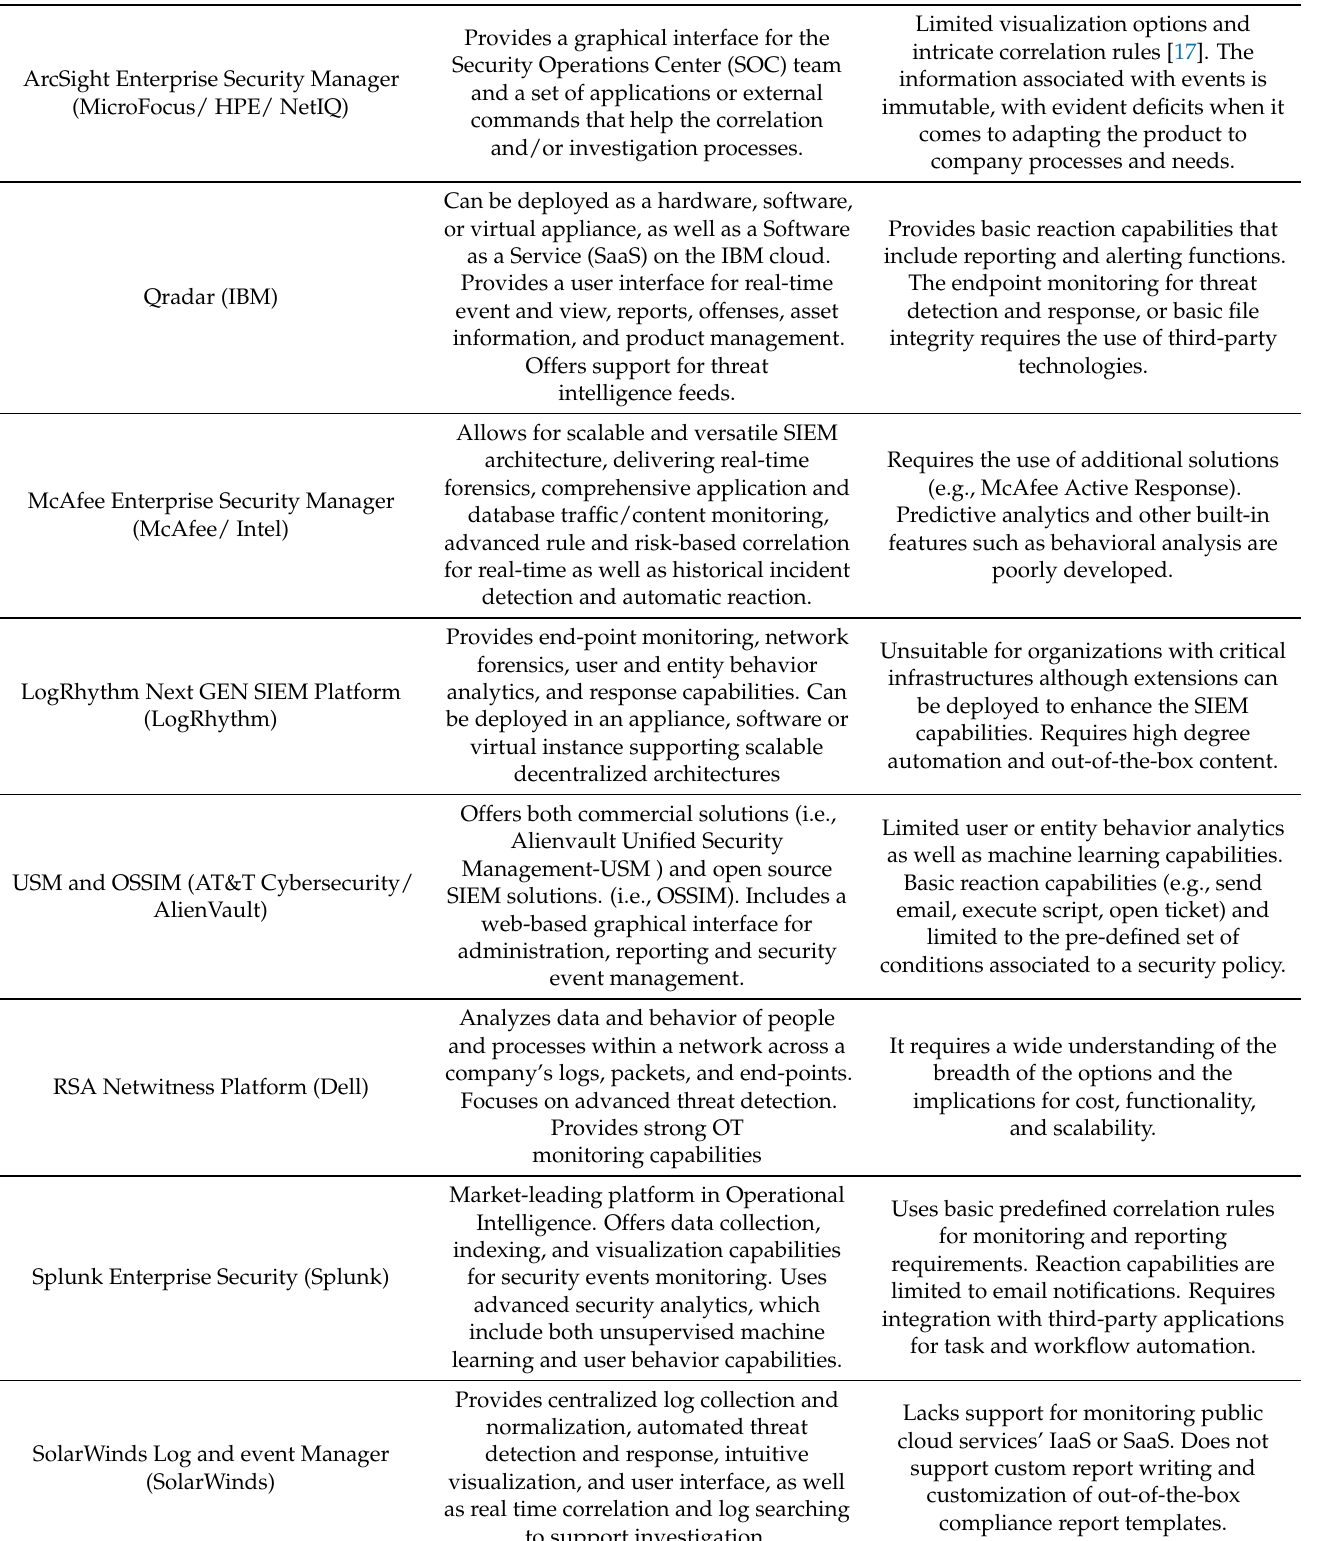
Table 2. SIEM tools/vendor